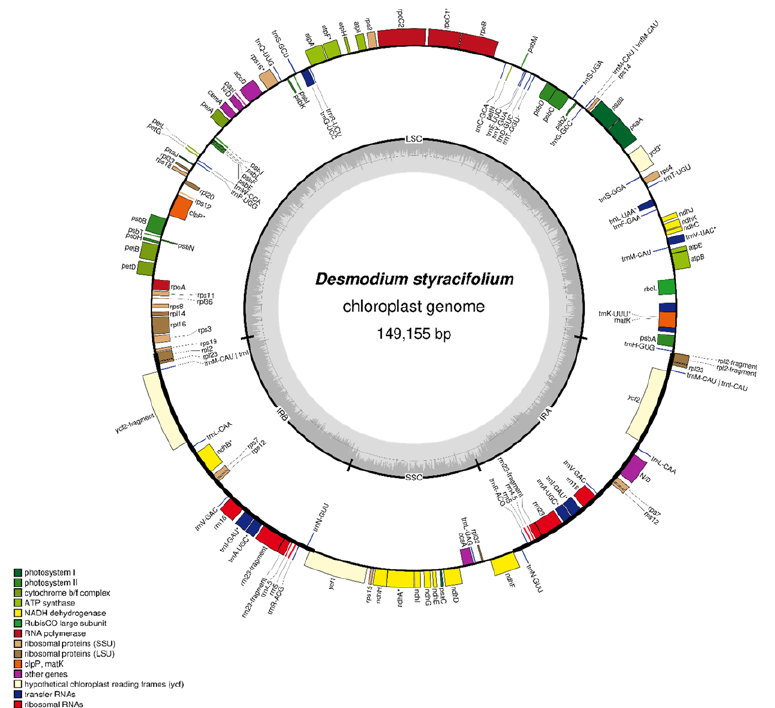
Figure 1. Gene map of Desmodium styracifolium . The genes outside the circle are transcribed counterclockwise, while those inside is transcribed clockwise. Genes are color based on the identified functional groups.